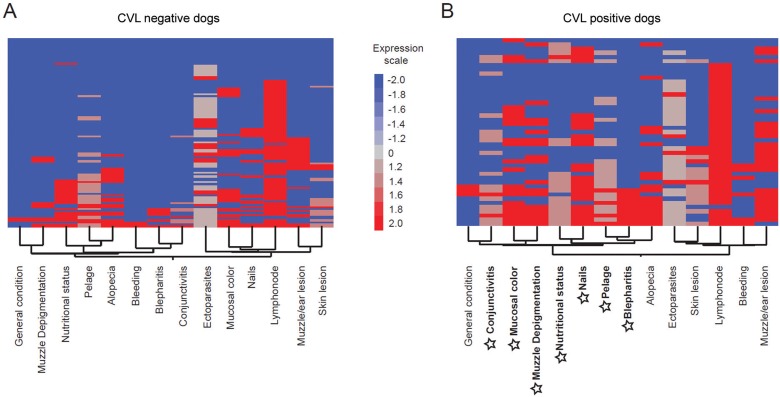
: heat map analysis of the clinical signs of dogs according to canine visceral leishmaniasis (CVL) status. Two-way hierarchical cluster analysis (Ward’s method) was performed to identify patterns of associations between different signs for CVL-negative dogs (A) and CVL-positive dogs (B). The colours show the fold variation from the median values (log transformed) calculated for each sign. Highlighted in bold and with star symbols are those signs with the highest association observed in CVL-positive dogs in Fig. 3C.